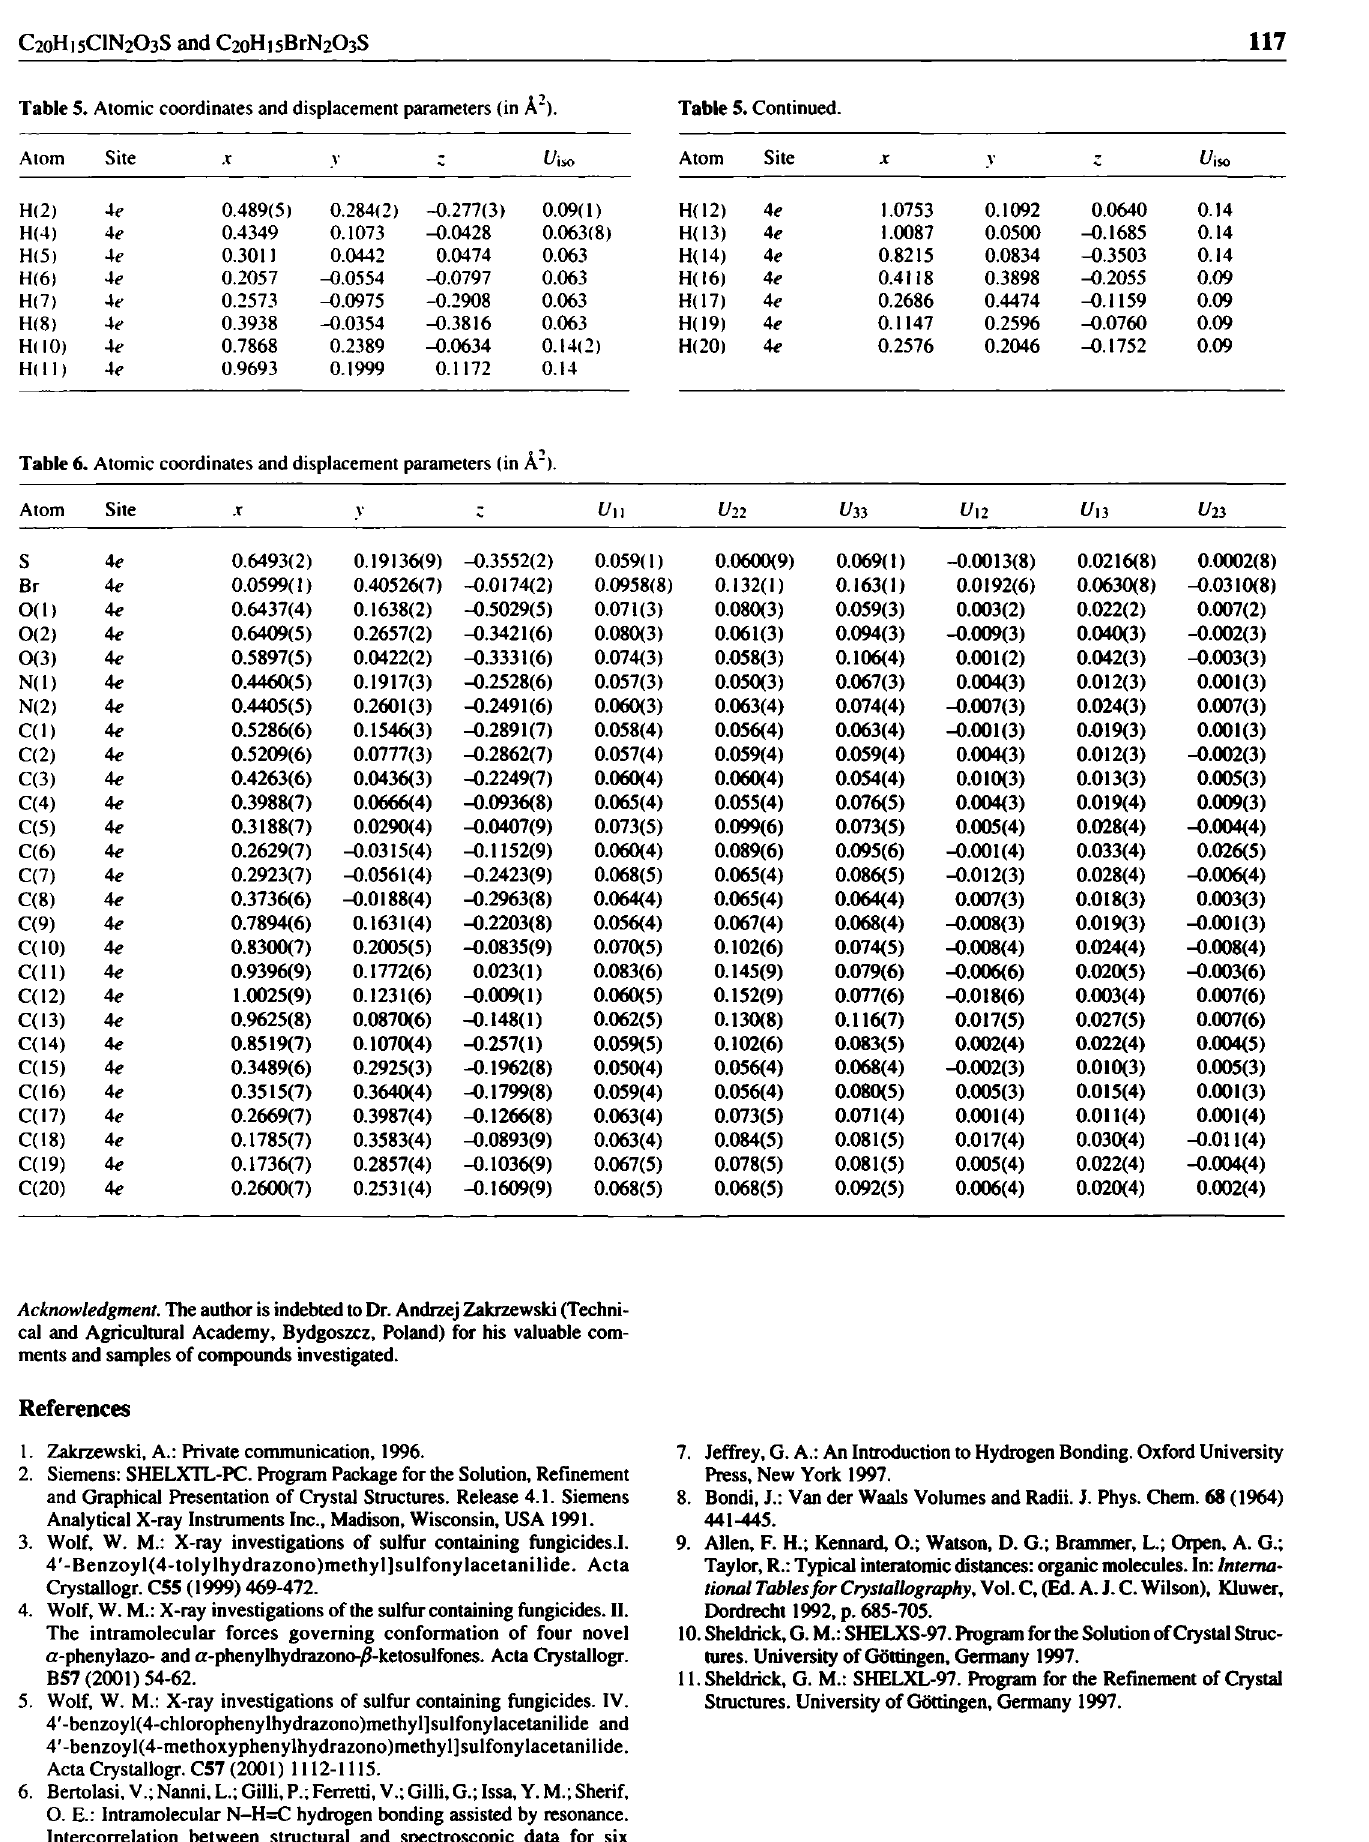
Table 5. Atomic coordinates and displacement parameters (in k 2 ).